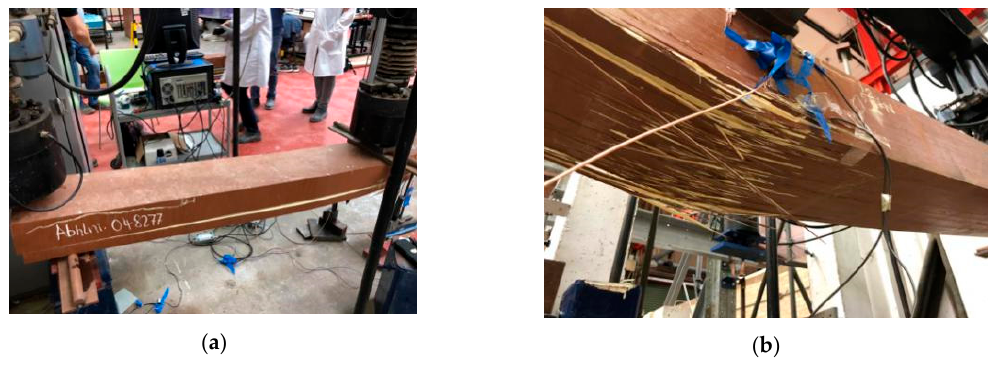
Figure 6. Failure mode of full-scale FFU composite beams under ( a ) single ultimate load;